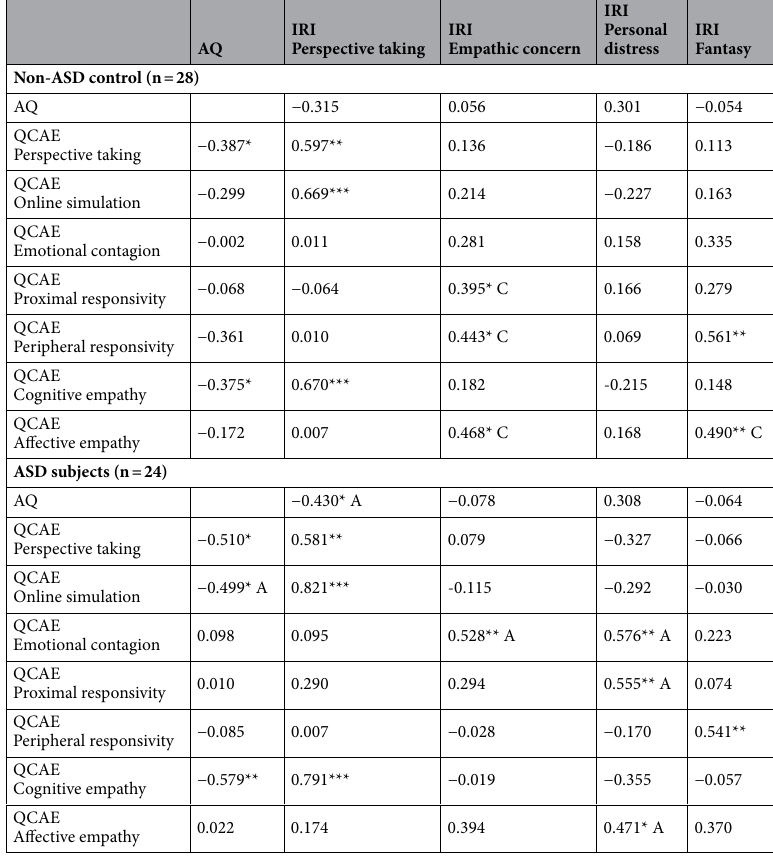
Table 3. Relationships between empathy’s components on the QCAE and IRI and autistic traits on the AQ. Values are Pearson’s r correlations. AQ autism-spectrum quotient, IRI Interpersonal Reactivity Index, QCAE Questionnaire of Cognitive and Affective Empathy, C only within non-ASD control subjects, A only within ASD subjects. * p < 0.05,** p < 0.01,*** p < 0.001 in each